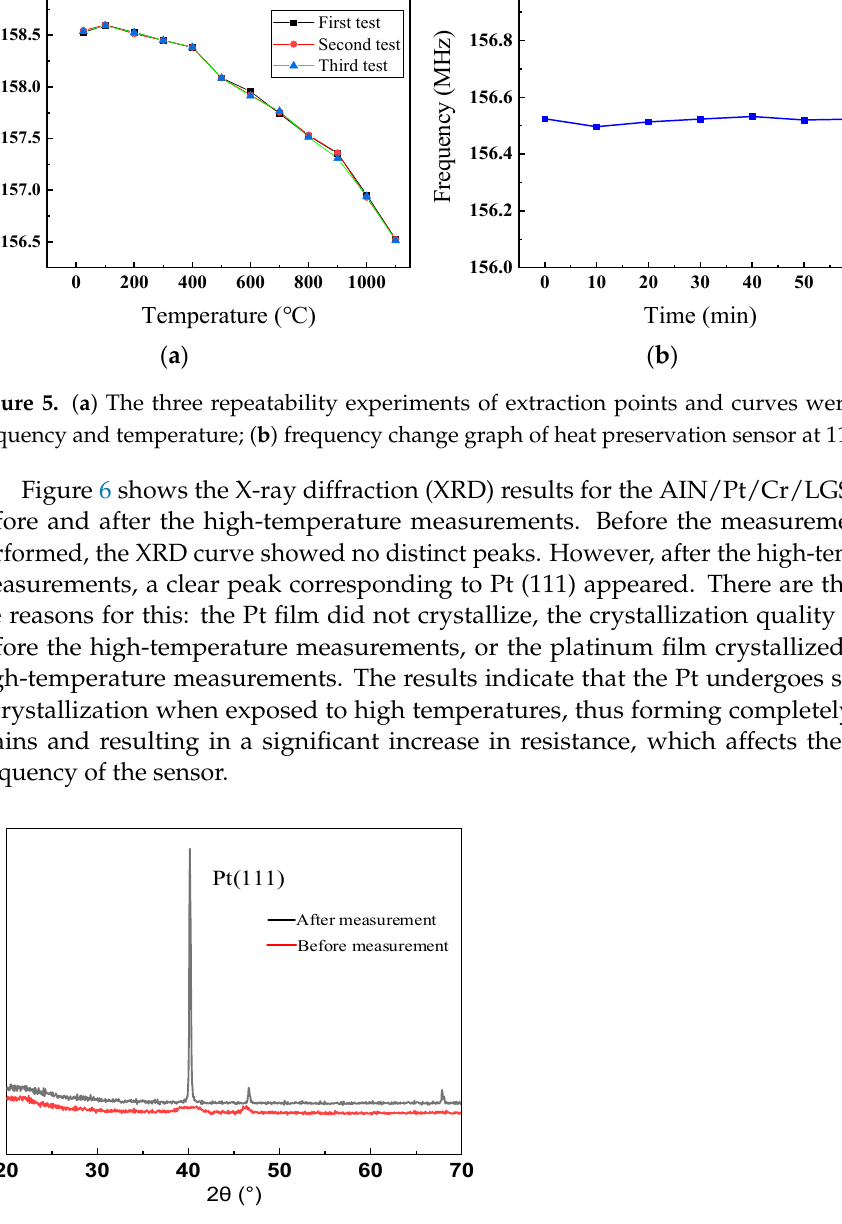
Figure 6. θ –2 θ scans of AlN/Pt/Cr/LGS samples before and after high temperature measurement. After treatment at high temperature, the adhesion of the AlN/Pt/Cr film to the substrate was very good. After the first high-temperature test at 1300 ◦ C, the